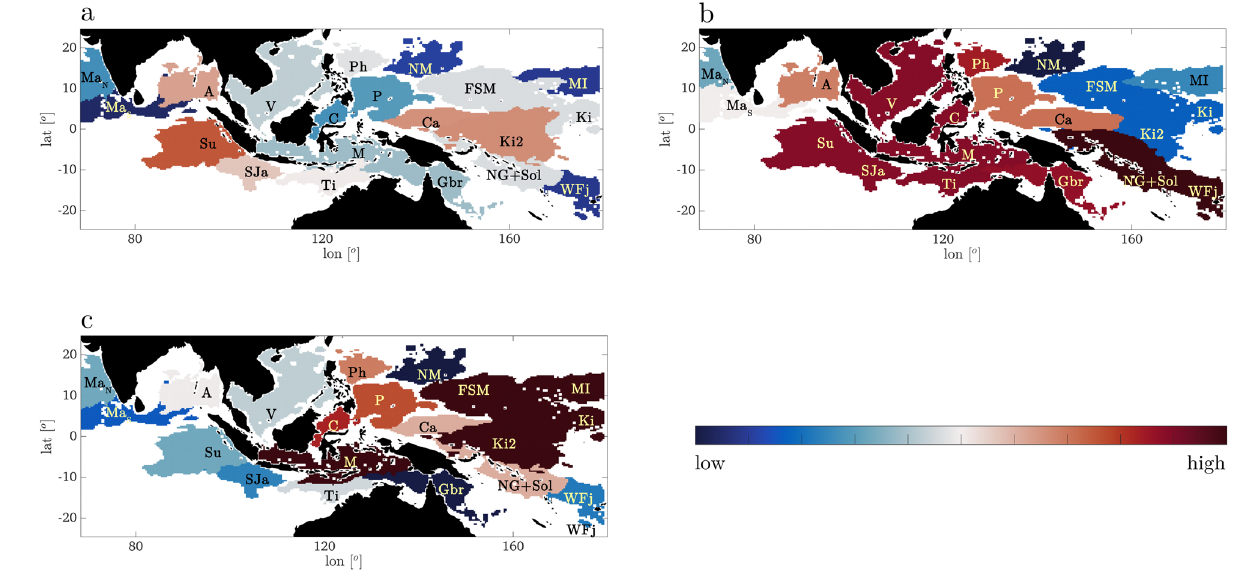
Fig. 4 Estimated Biodiversity Score over 1993 – 2017. Domains found during El Nino years, colored according to their Biodiversity Score in ( a ) El Niño years, ( b ) La Niña years, ( c ) neutral years. The color scale is linear (low = 0.03, high =